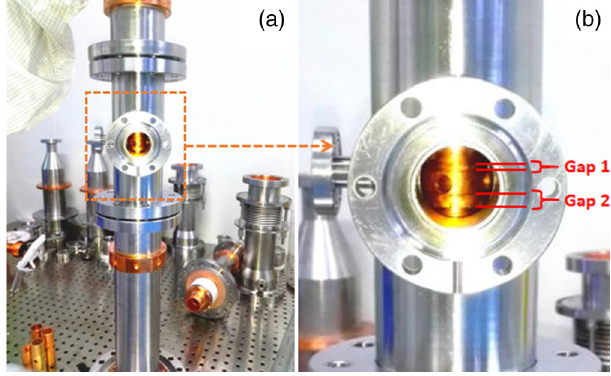
FIG. 9. Connection of the two fundamental couplers to be tested. (a) presents the coaxial connector between the two couplers; (b) depicts the gaps preserved on both sides of the core insert.